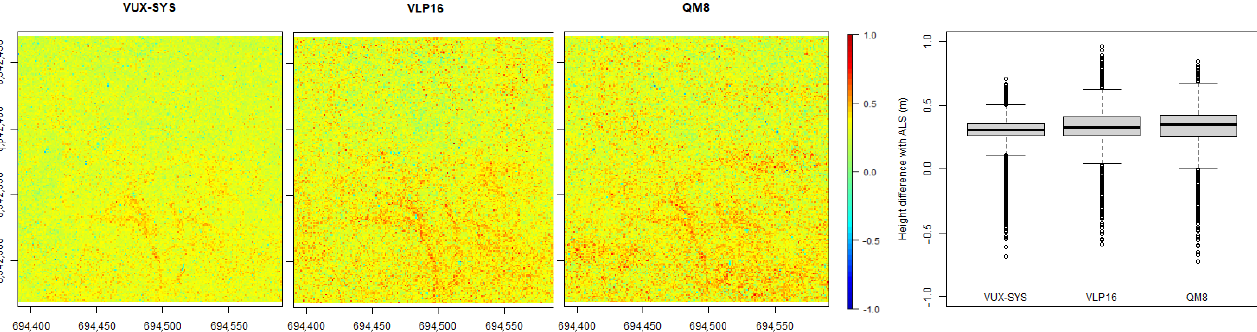
Figure 8. Difference maps of the UAV–LiDAR-derived digital terrain models and the ALS DTM. The three maps show the absolute differences spatially. The boxplot shows a summary of the differences for all pixels in the study area. The area shown covers the 200 × 200 m study area; coordinates on the x and y axes are given in UTM Zone 52S.